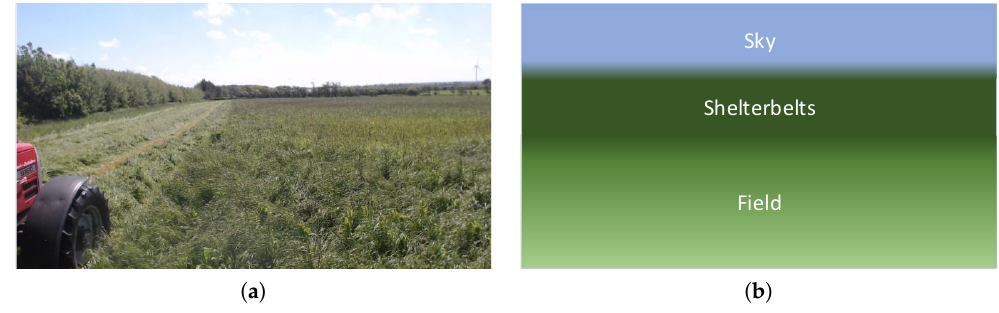
Figure 1. The visually homogenous characteristics of an agricultural field. ( a ) Shows agricultural field from tractor implement. ( b ) Illustration of the few visual components in an agricultural field.